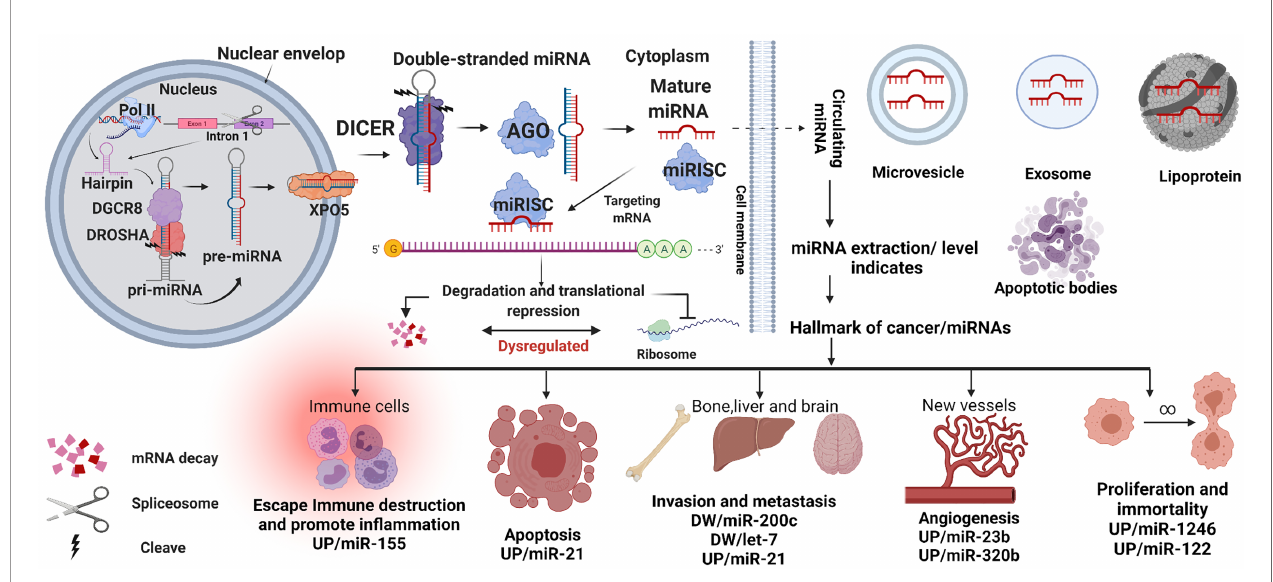
FIGURE 1 | MiRNA biogenesis. miRNA genes or spliced introns are transcribed by polymerase II (Pol- II) as primary miRNA (pri-miRNA). The pri-miRNA is subsequently cleaved by Drosha along with DGCR8 proteins to generate the pre-miRNAs. The pre-miRNAs are then exported to the cytoplasm by Exportin-5 (XPO5) and cleaved again by DICER1 to form a short double- stranded miRNA. Together with Argonaute (AGO), this double-stranded miRNA is unwound into a mature miRNA (single strand) and loaded as a guide for the miRNA-induced silencing complex (miRISC) to target the UTRs or CDSs of the mRNA. Based on the mature RNA sequences, miRISC could repress mRNA expression. The mature miRNA can export from the cell and reaches the bloodstream as lipoproteins, exomes, microvesicles, and apoptotic bodies. Which can be used as a marker for cancer-based on their expression levels, UP or DW (down) — created with